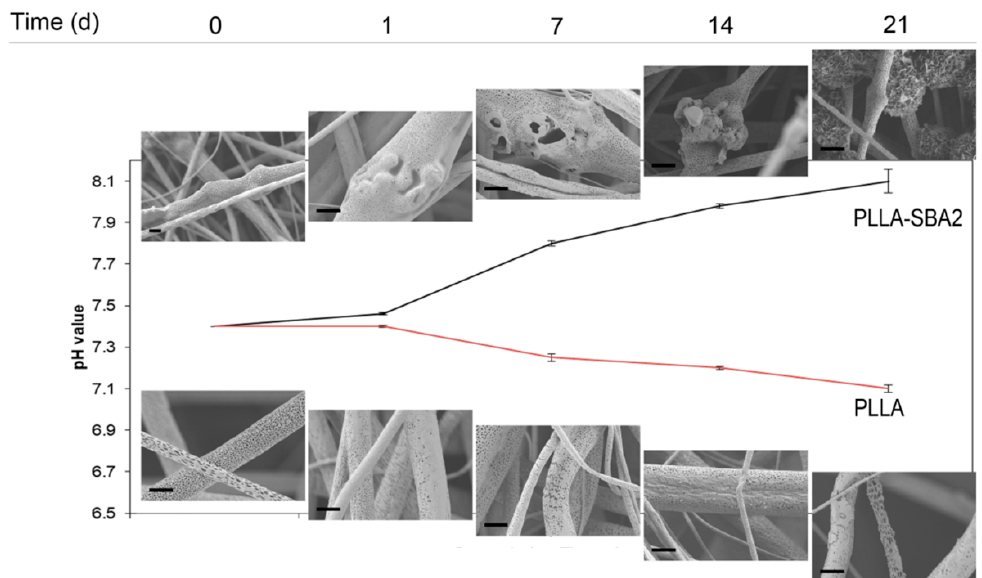
Figure 5. In vitro degradation studies and dissolution of PLLA and PLLA-SBA2 electrospun fibres. Change in the pH of DPBS solution for PLLA and PLLA-SBA2 fibres, which is associated to the acid hydrolysis of the polymer components and to the release of SBA2 into the solutions at 0, 1, 7, 14, 21 days from incubation and the relatives SEM micrographs at high magnification of composite and polymeric fibres along soaking experiments in SBF at the same time point (scale bar = 2 µm).